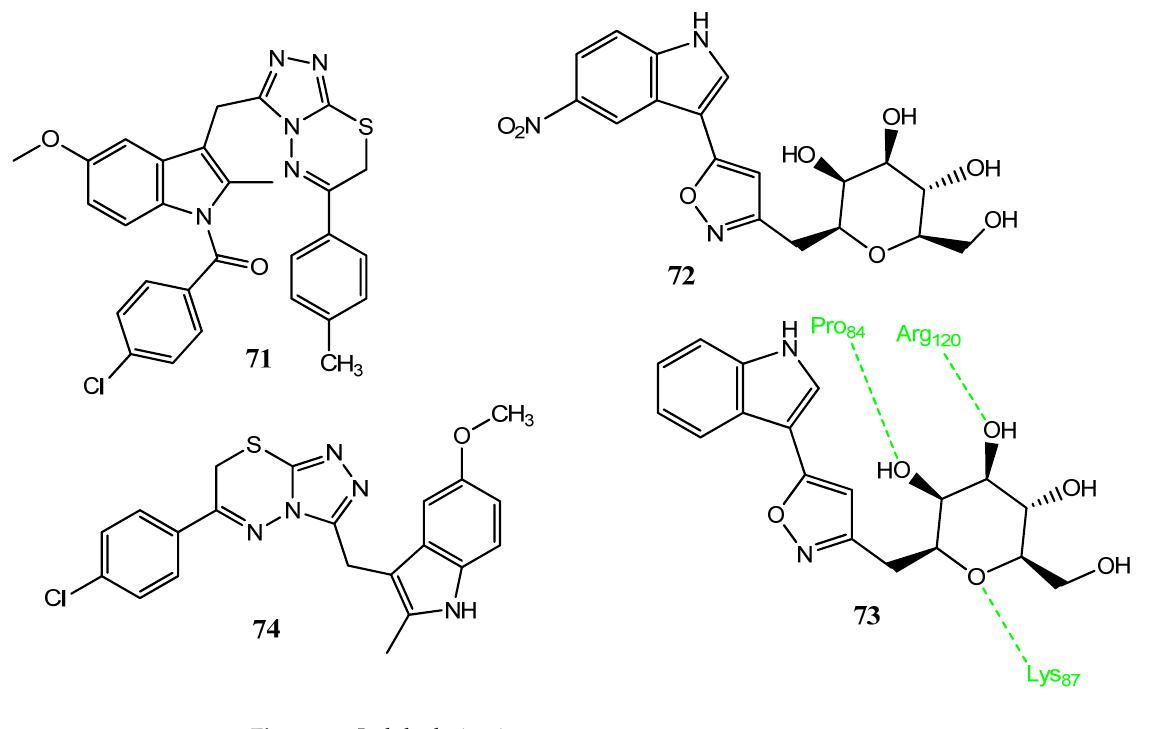
Figure 15. Indole